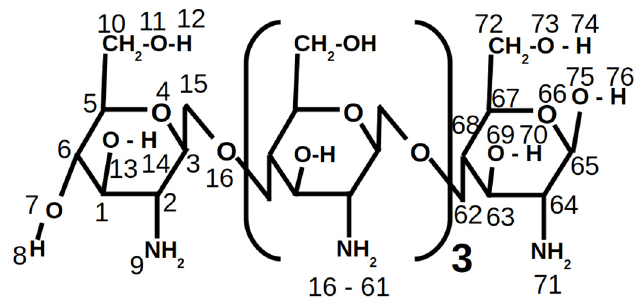
Figure 1. Chitosan model used in our simulations, in which the atom numeration used for its atomic charge distribution is included.